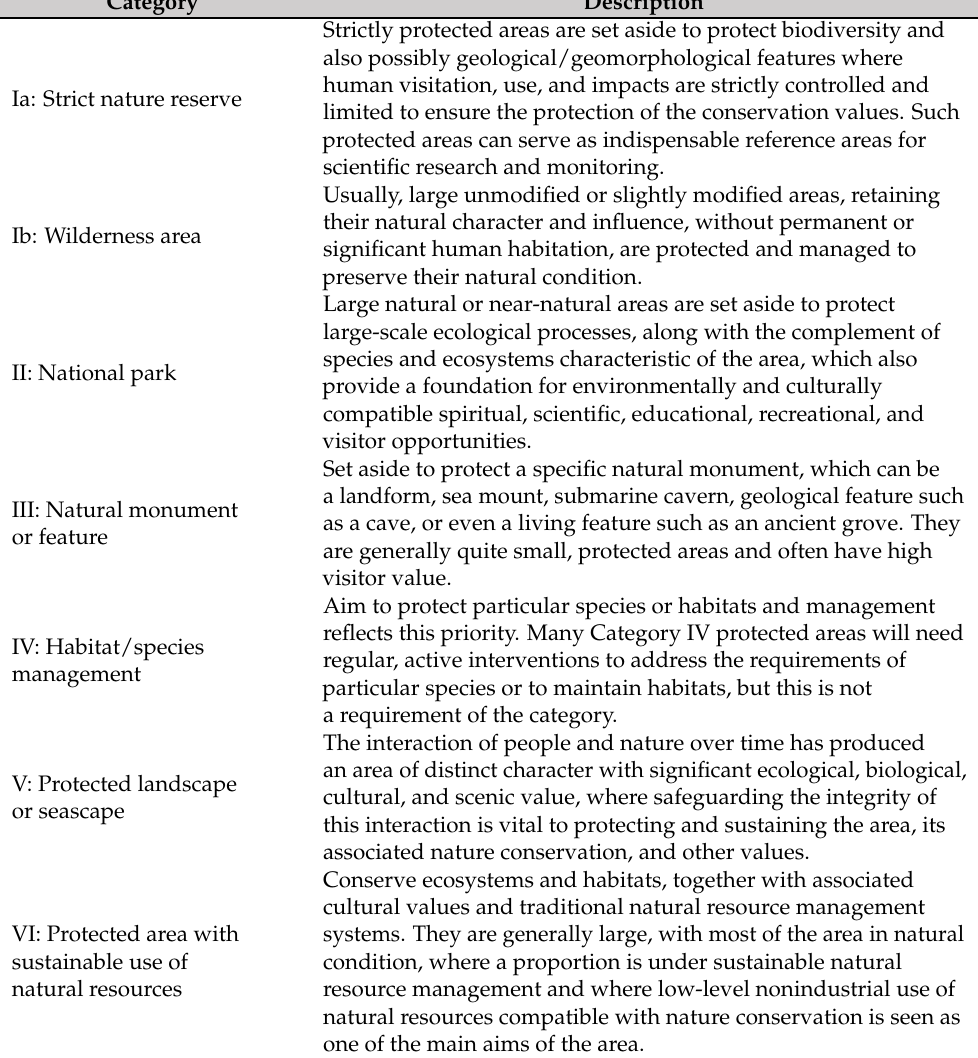
Table 1. Summary of the six PA categories recognized by IUCN (Adapted from Ref. [3]. Copy- right